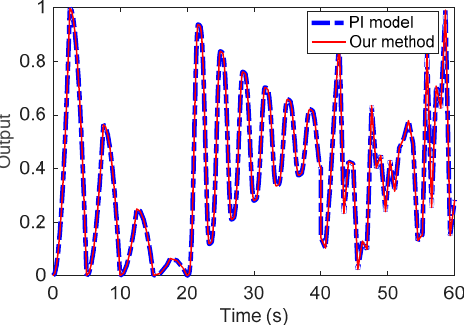
Figure 7. Output signals of the PI model and the presented method. Table 1. Parameters of the Prandtl-Ishlinskii (PI) model.